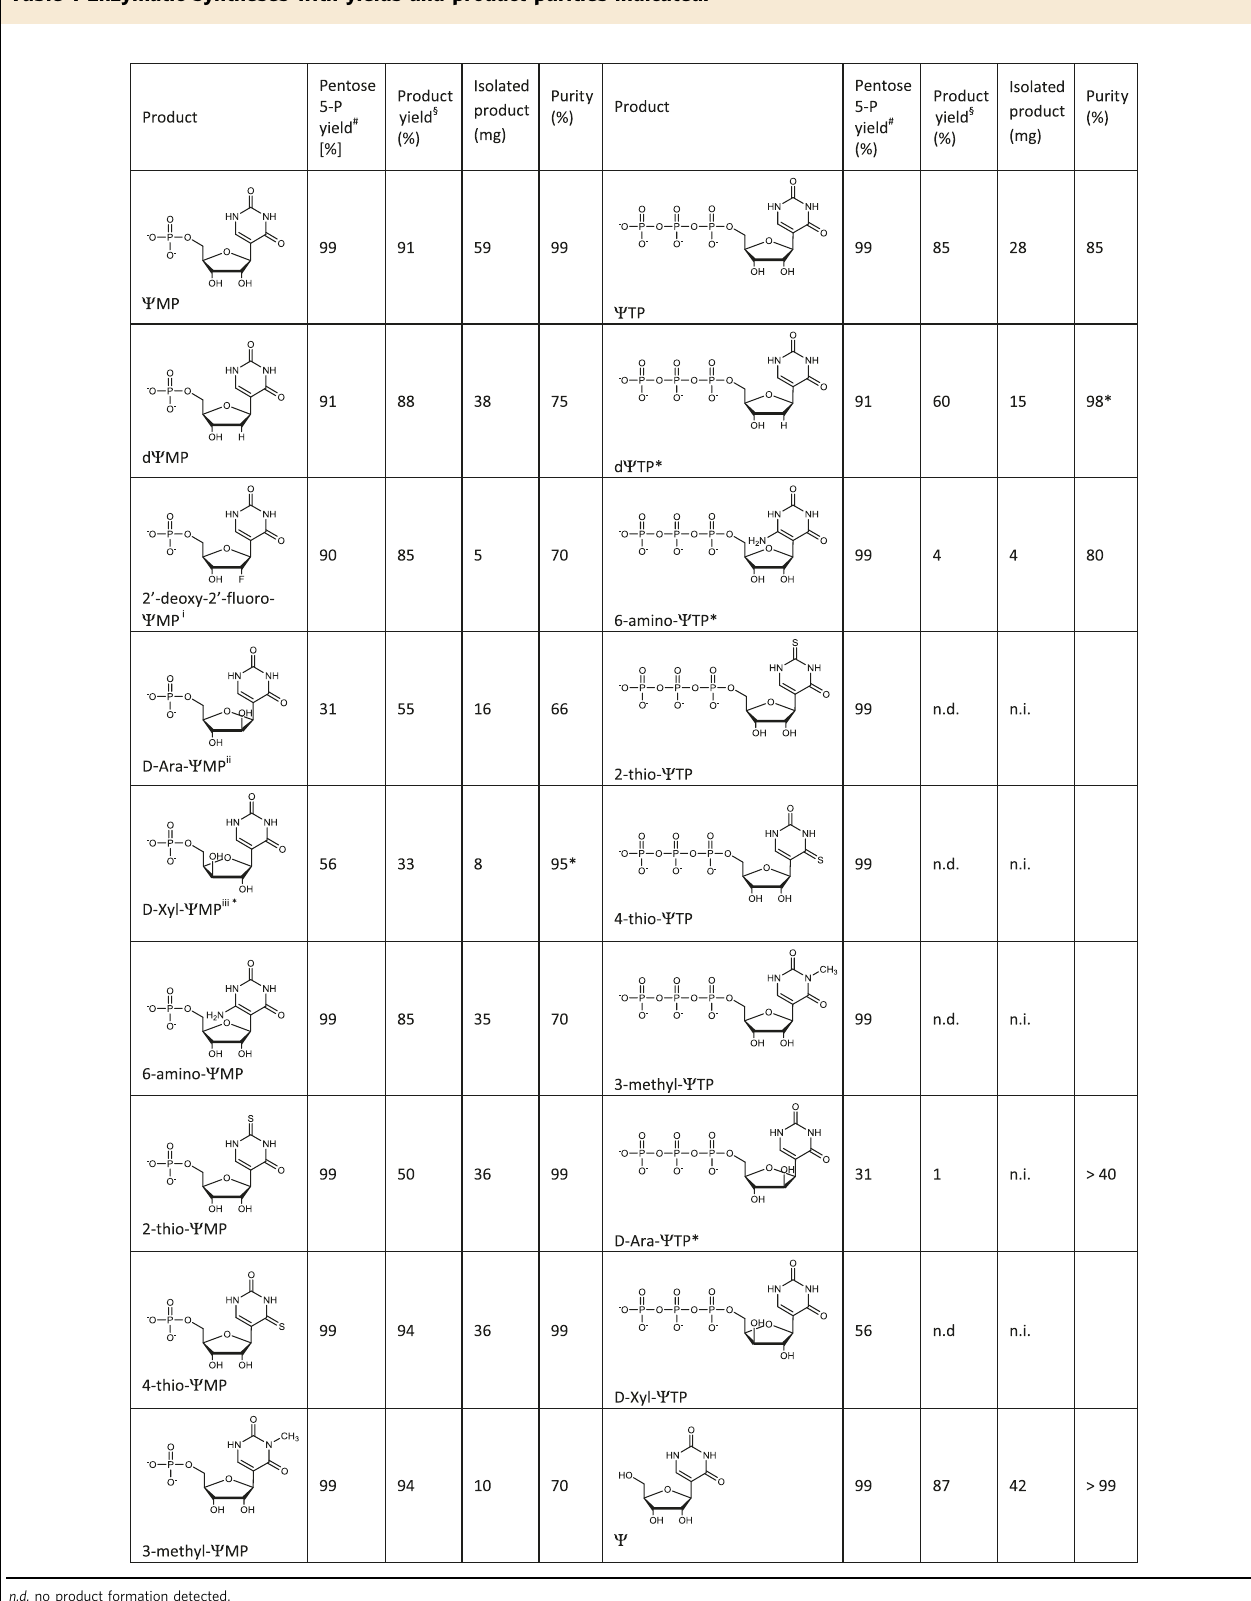
Table 1 Enzymatic syntheses with yields and product purities